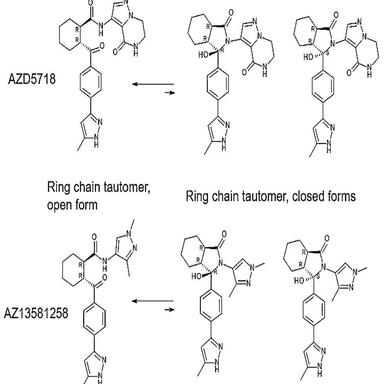
Chemical structures of AZD5718 and AZ13581258 with suggested tautomer equilibria between an open structure and a ring-chain closed diastereoisomeric pair (I and II, not assigned).